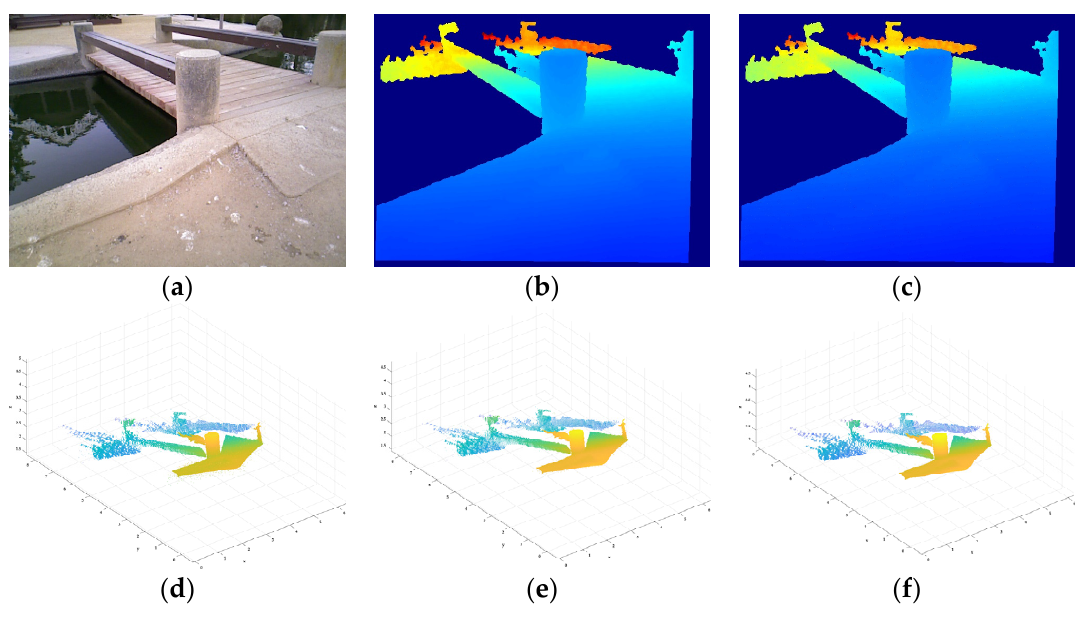
Figure 11. Denoising effects of fractional integral denoising and median filtering. ( a ) RGB image